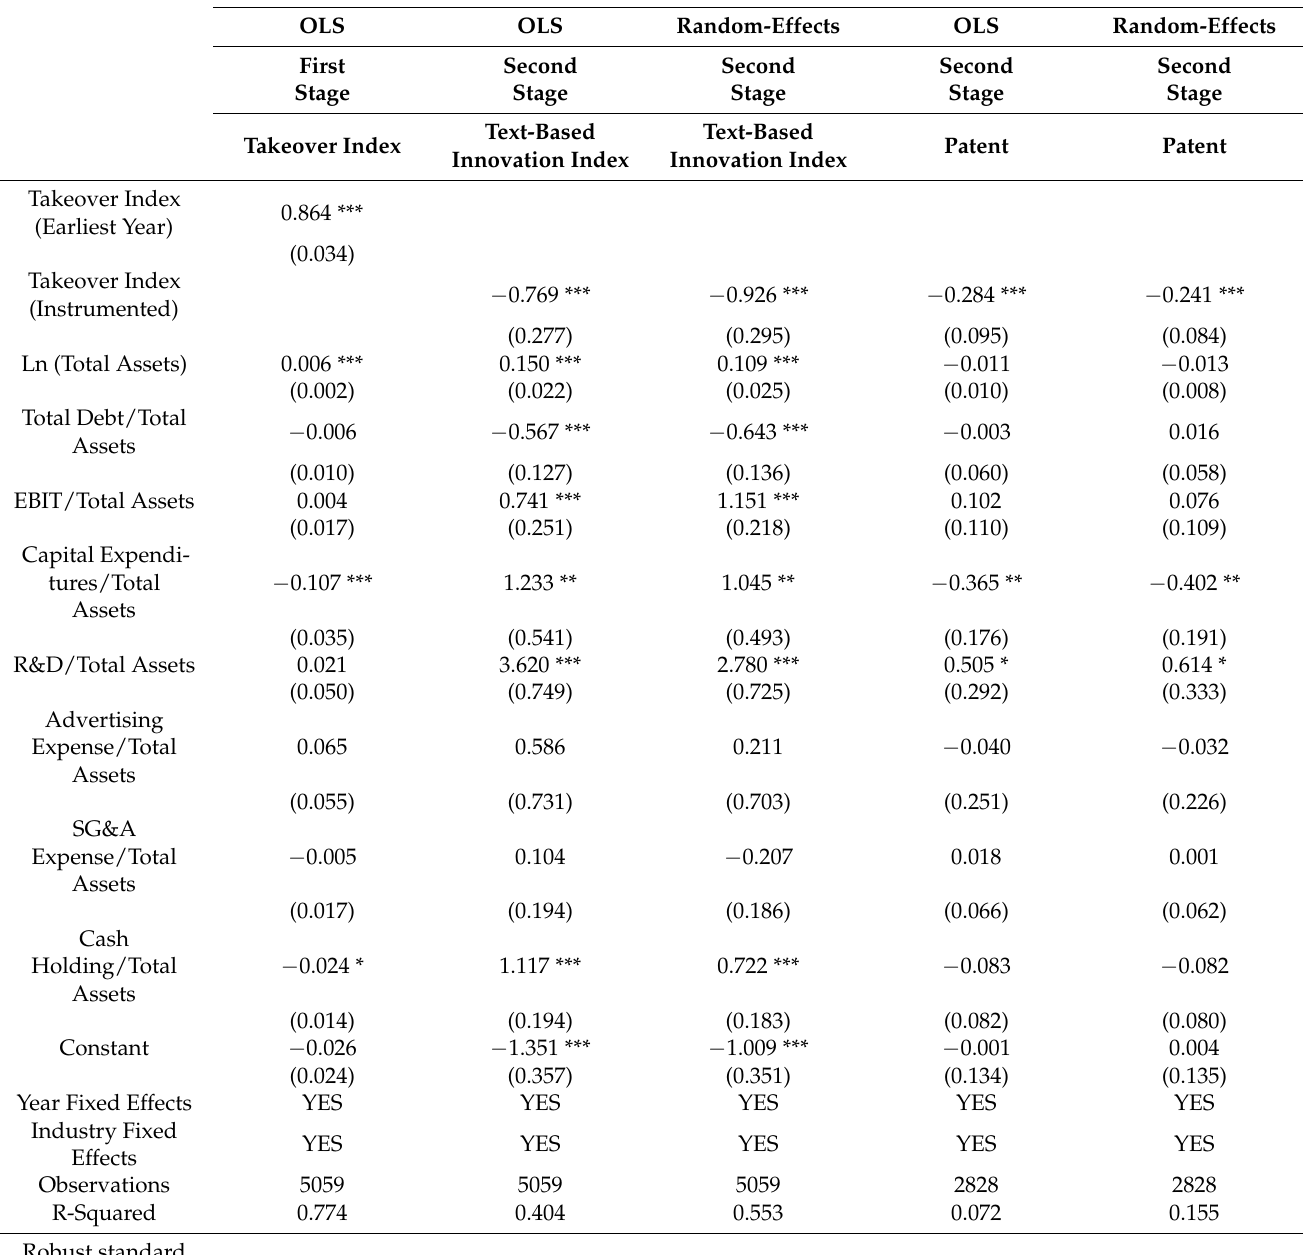
Table 4. Instrumental-variable analysis using takeover index in the earliest year in the